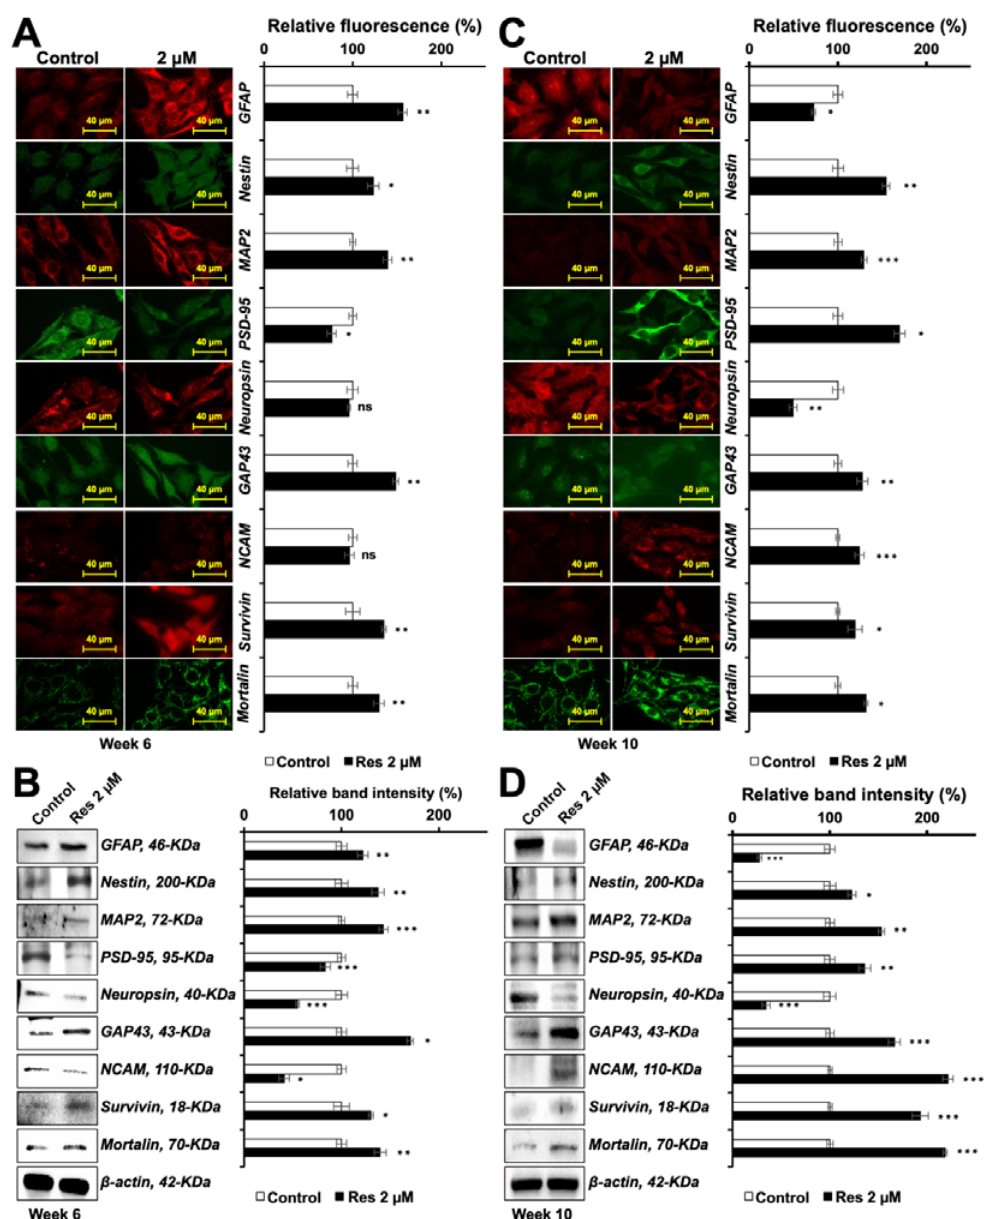
Figure 6. Molecular basis for biphasic differentiation induced by resveratrol (Res) in C6 glioma: Immunostaining and Western blotting (quantification shown in histograms) for proteins specifically expressed in glial and neuronal cells. C6 cells treated with resveratrol for 6 weeks (Glial phenotype, A and B ) and 10 weeks (Neuron phenotype, C and D ) were used.